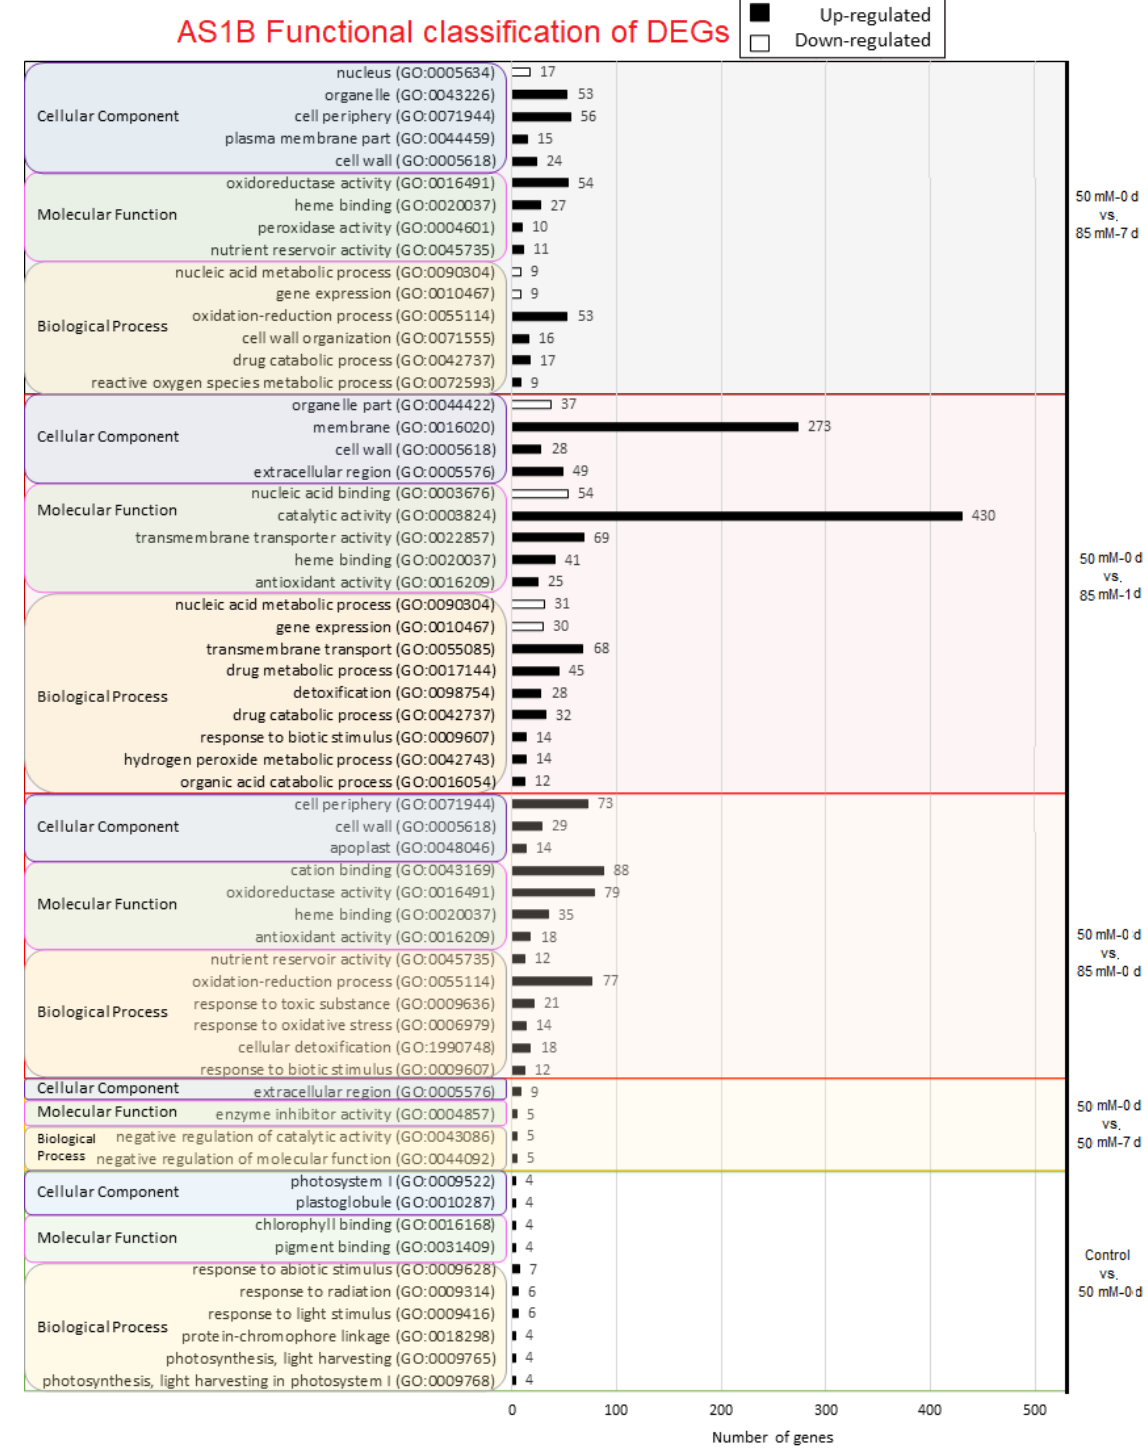
Figure 3. Panther output of GO results obtained in DEG analysis in AS1B under different comparisons: Control vs. 50 mM-0 d (in green region), 50 mM-0 d vs. 50 mM-1 d (brown region), 50 mM-0 d vs. 50 mM-7 d (yellow region), 50 mM-0 d vs. 85 mM-0 d (red region), and 50 mM-0 d vs. 85 mM-7 d (gray region). Number of GO detected are expressed in upregulated (black bars) and downregulated (white bars) GO functions. For each comparison, 3 GO levels are shown: biological process (gray-outlined yellow box), molecular function (pink-outlined green box regions), and cellular component (violet-outlined gray box).